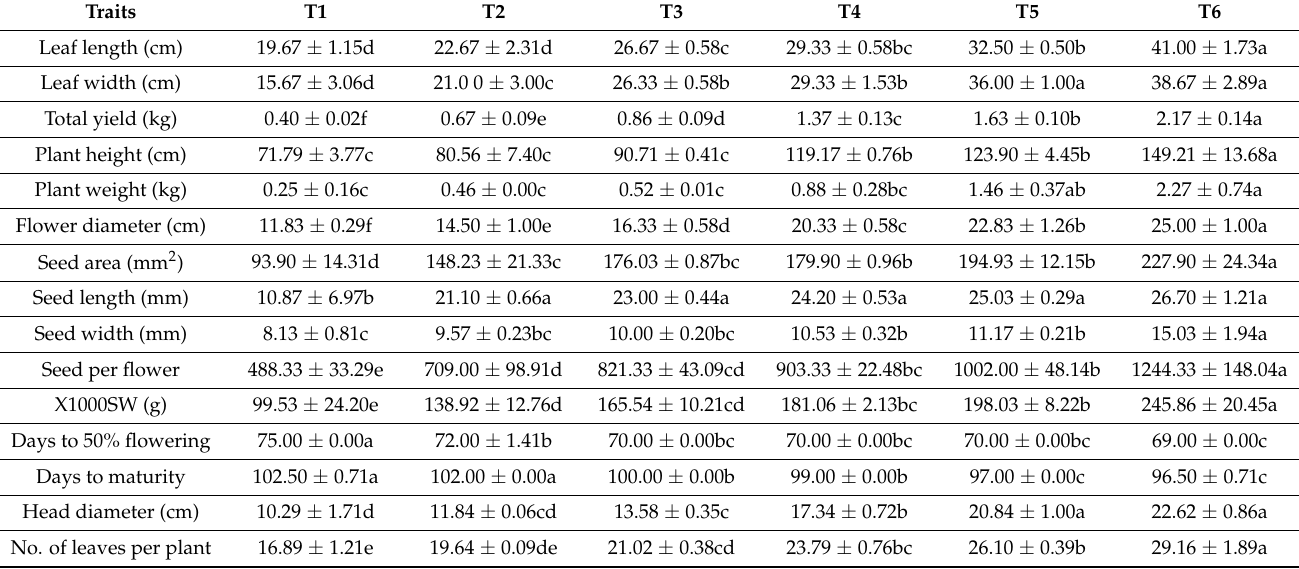
Table 2. Effects of different treatments on various morphological characteristics of